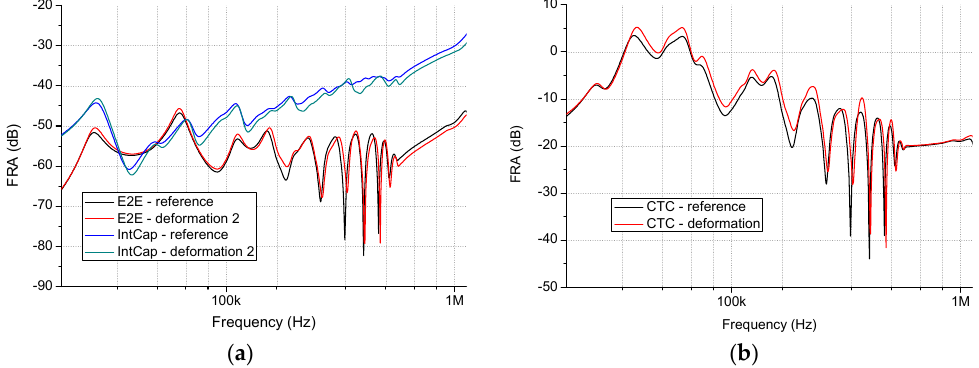
Figure 5. Laboratory transformer FRA test results for deformation 2 in MF range: ( a ) E2E and IntCap, ( b ) CTC.